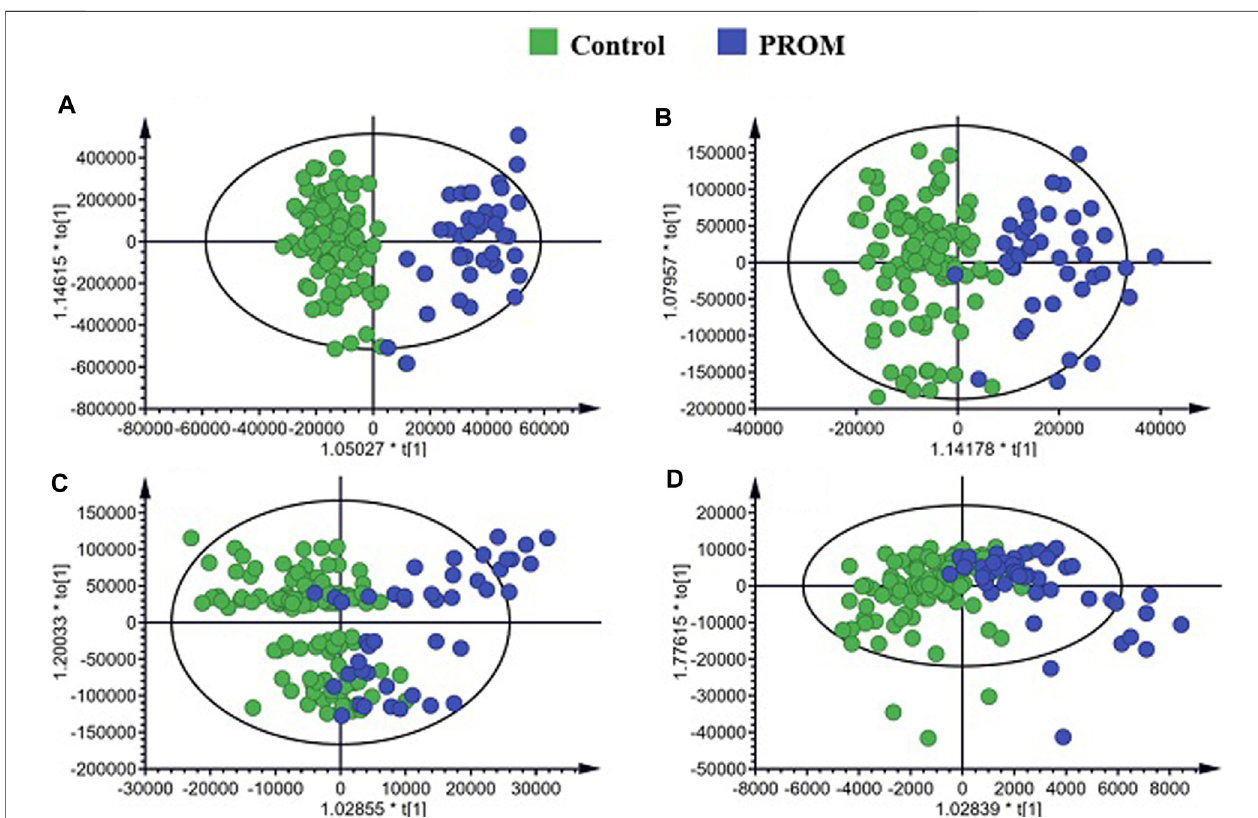
FIGURE 2 | Orthogonal partial least squares discriminant analysis (OPLS-DA) score plots and random permutation tests of the non-polar metabolites. (A) Score plots of polar metabolites for positive ion mode; (B) polar metabolites for negative ion mode; (C) non-polar metabolites for positive ion mode; (D) non-polar metabolites for negative ion